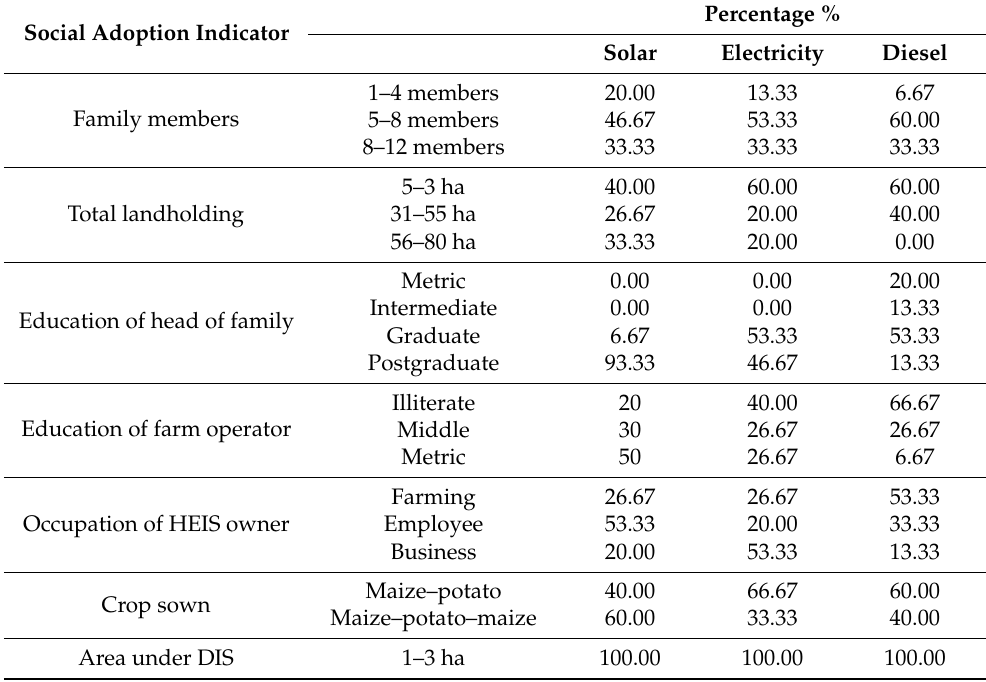
Table 6. Variables of the study for social